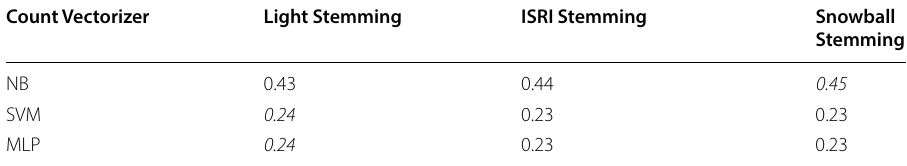
The italic values indicate the highest accuracy (best one)